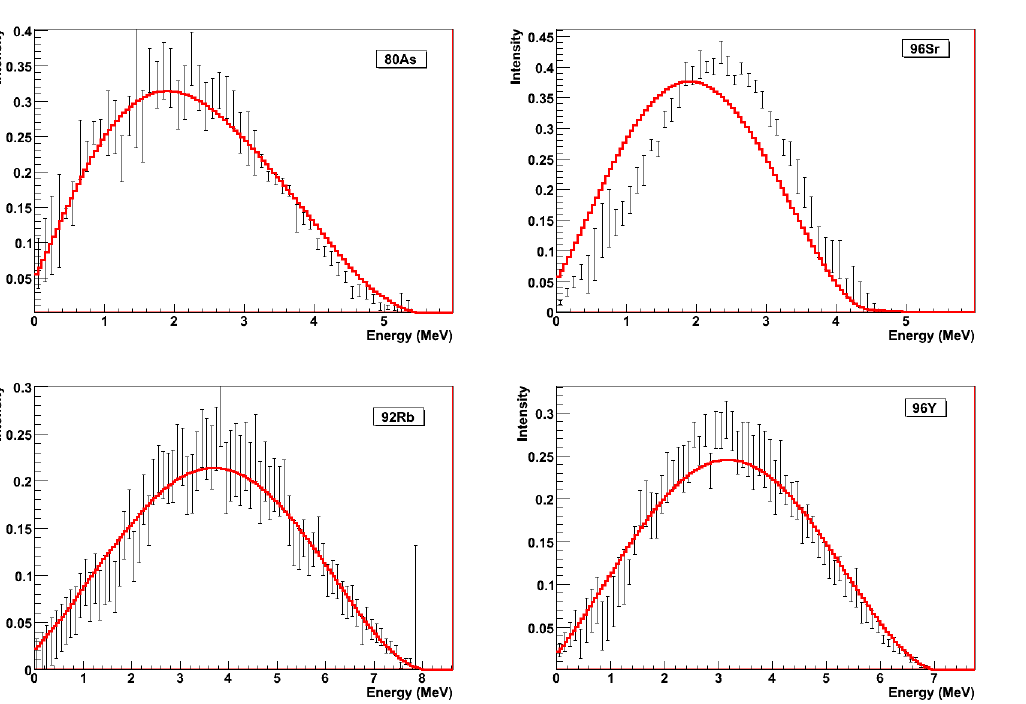
Figure 2. Examples of calculated energy spectra for almost pure allowed transitions ( 80 As, 96 Sr) and dominant non-unique first-forbidden transitions ( 92 Rb, 98 Y) compared with the Rudstam data